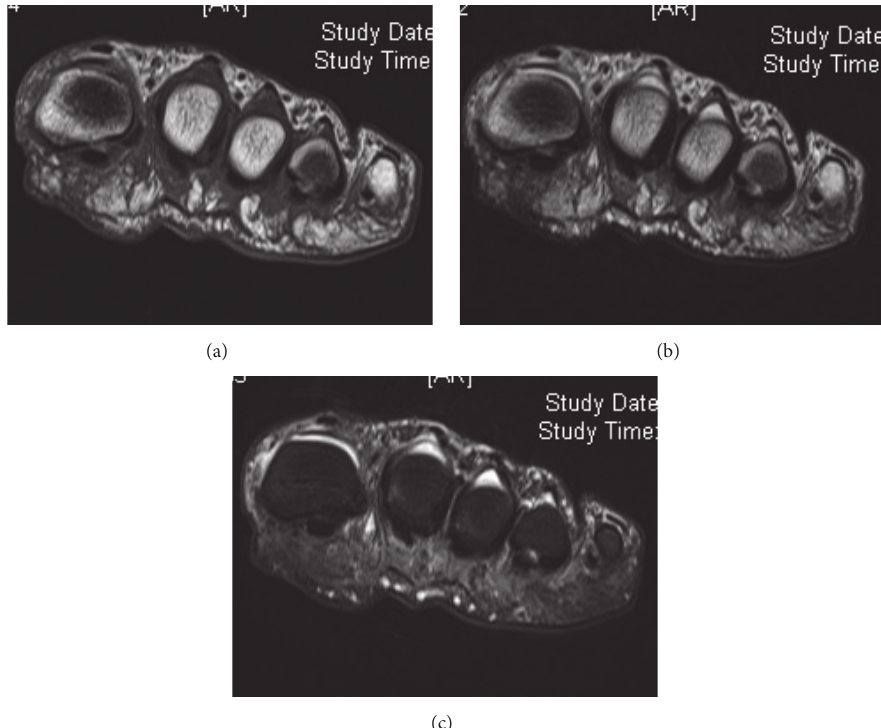
Figure 1: Magnetic resonance images of the distal metatarsals showing an upside-down bulbous-shaped mass with low-signal intensity in T1-weighted (a), T2-weighted (b), and short-tau inversion recovery image (c) extending dorsally between the second and third metatarsal